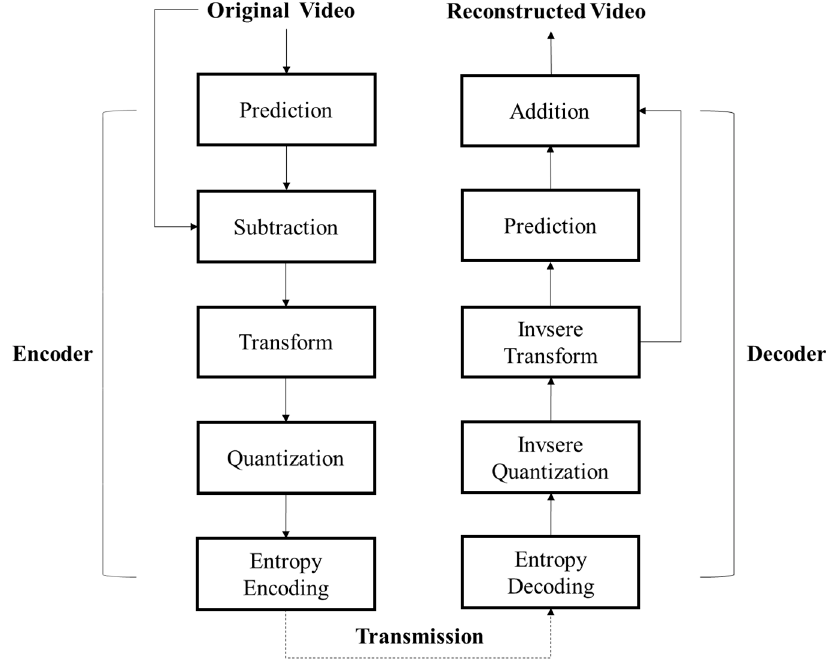
Figure 3. General video compression process.